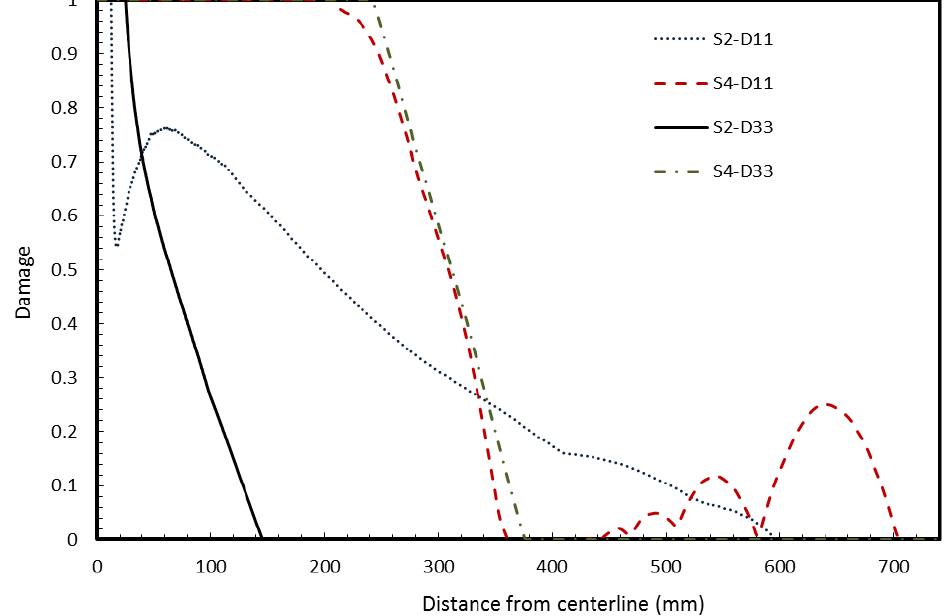
Figure 7. Damage variables D surface S4 for a large missile (round end)